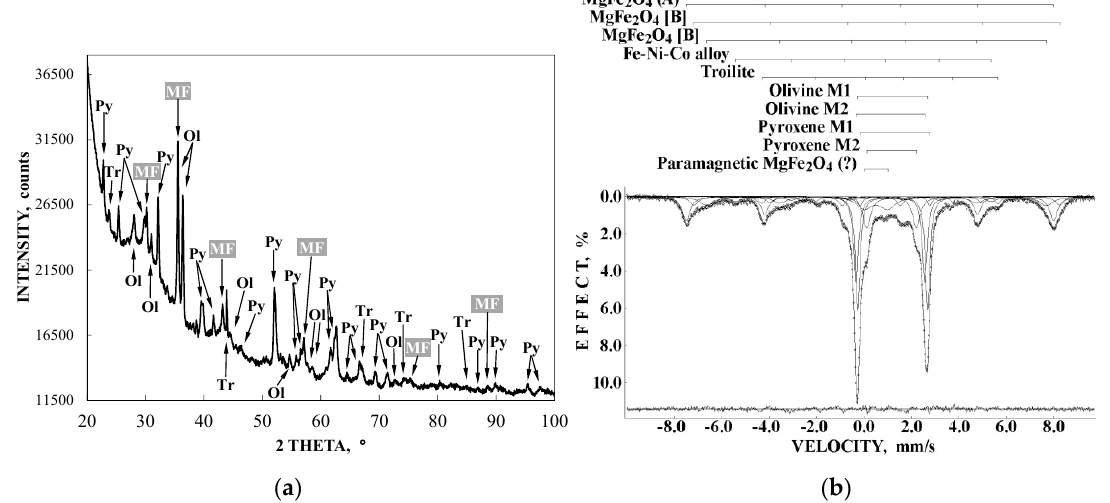
Figure 12. The fusion crust from Chelyabinsk LL5 fragment 1a: ( a ) X-ray diffraction pattern, arrows indicate reflexes of the main phases such as Ol (olivine), Py (pyroxene), Tr (troilite), and MF (magnesioferrite); and ( b ) Mössbauer spectrum measured at 295 K: indicated components are the result of the preliminary fit, the differential spectrum is shown below. Adopted from [10].